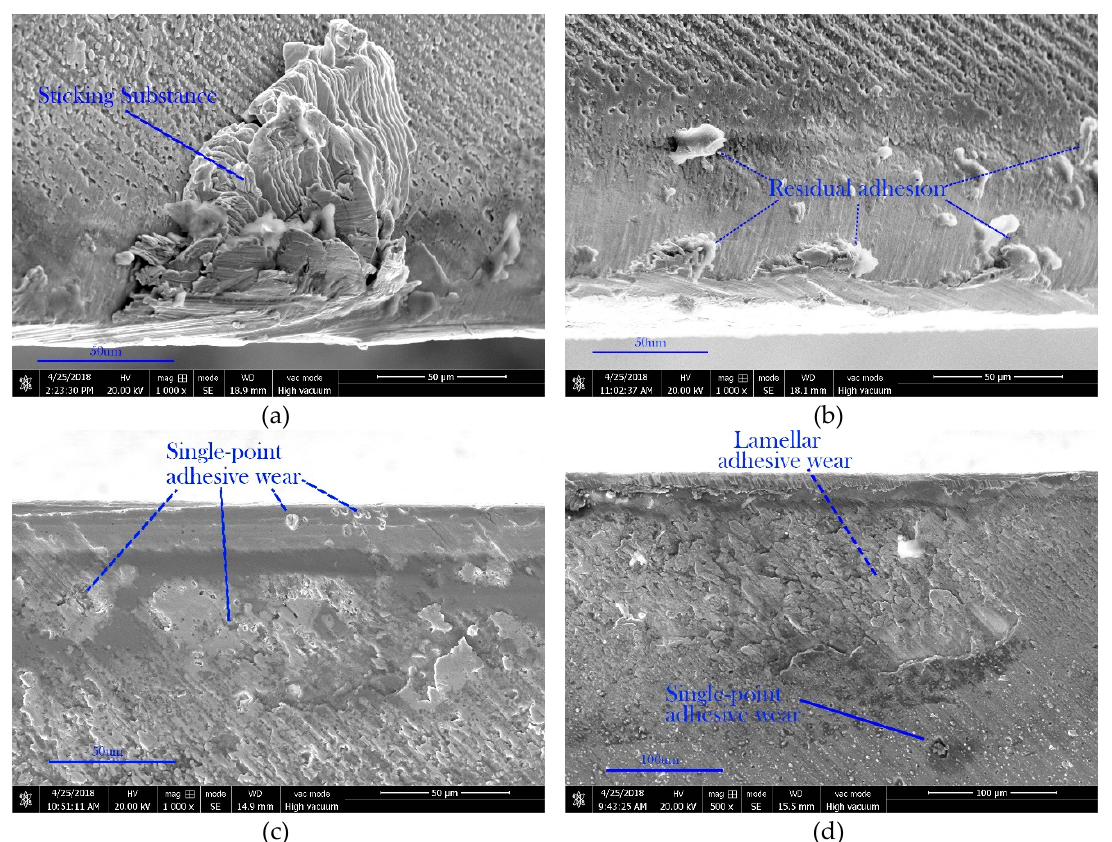
Figure 2. Sticking substance and adhesive wear. ( a ) adhesive morphology; ( b ) residual form of the adhesion; ( c ) single-point adhesive wear; ( d ) mixed wear pattern.